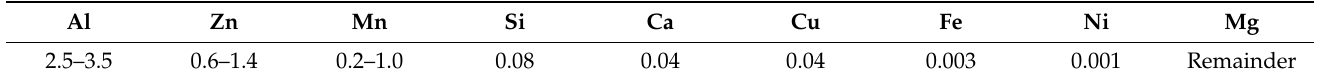
Table 1. Chemical composition of AZ31 magnesium alloy